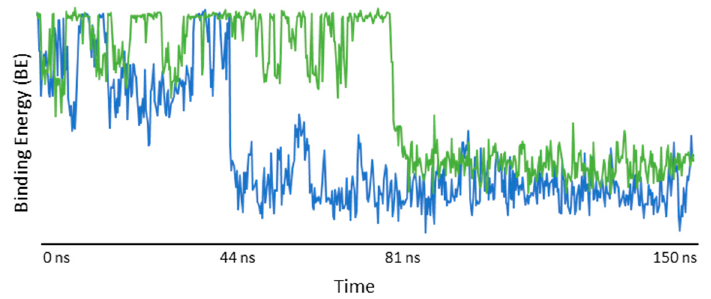
Figure 16. Optimized structure of IDE in the HP- β -CD cavity.